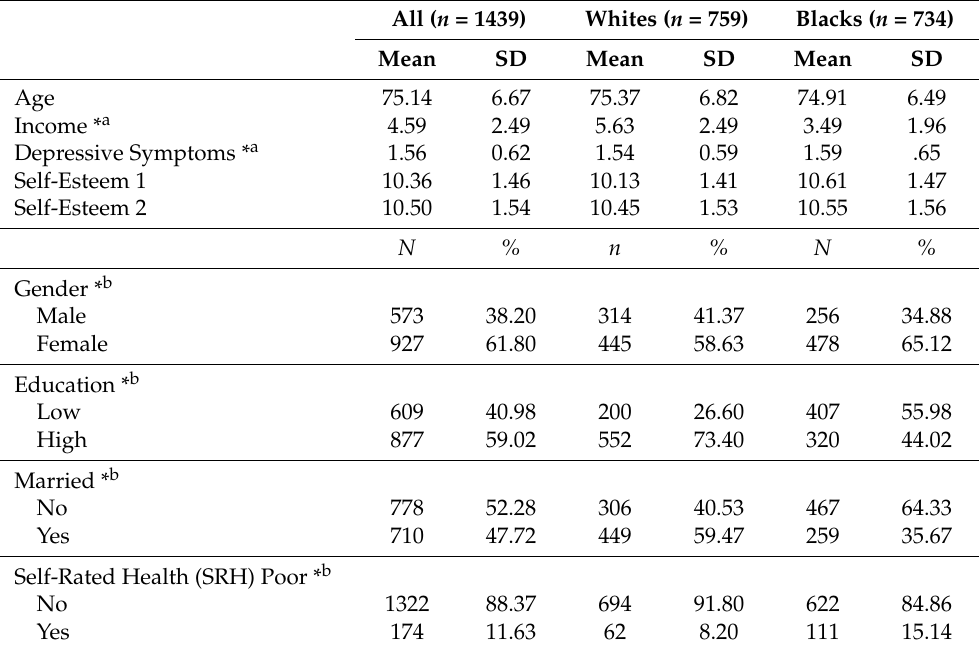
Table 1. Descriptive statistics in the pooled sample and by race/ethnicity.